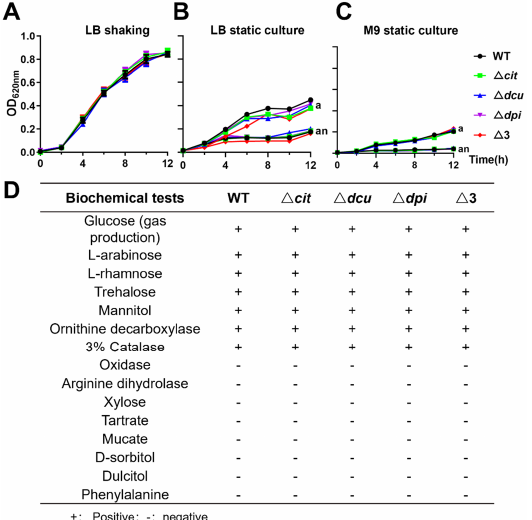
Figure 1. Deletion of TCSs of the CitB family did not affect the growth and the results of biochemical tests. ( A – C ) Growth curves of WT R51 and mutants under LB shaking conditions ( A ), LB static cul- ture ( B ) and M9 minimal medium static culture ( C ) (a, aerobic conditions; an, anaerobic conditions). ( D ) The biochemical test results of WT and mutants.